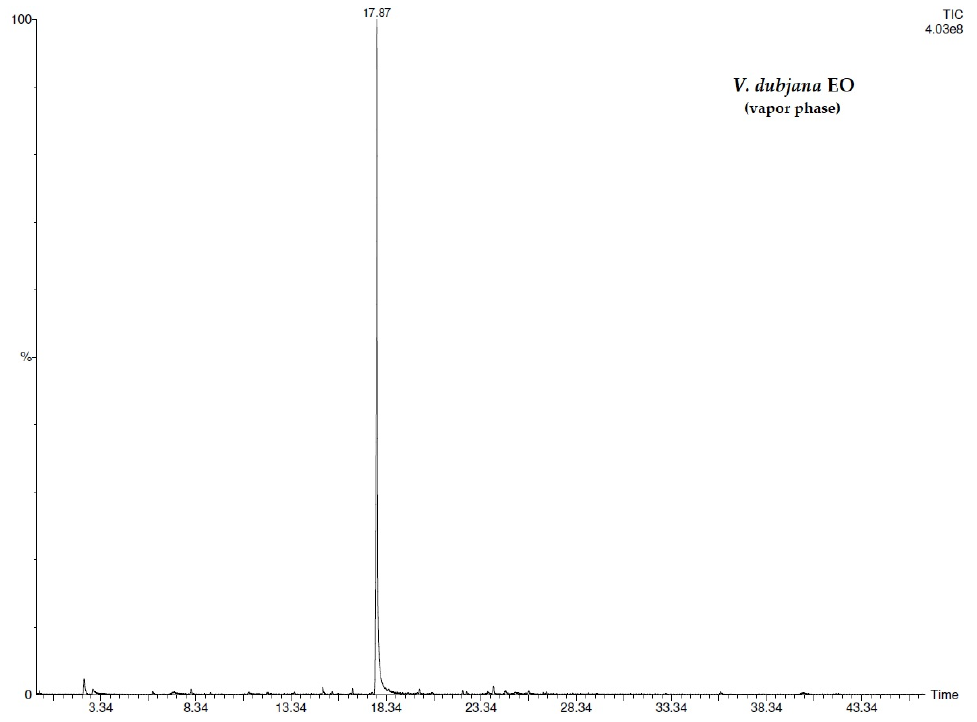
Figure 4. SPME/GC-FID chromatograms of V. dubjana EO.